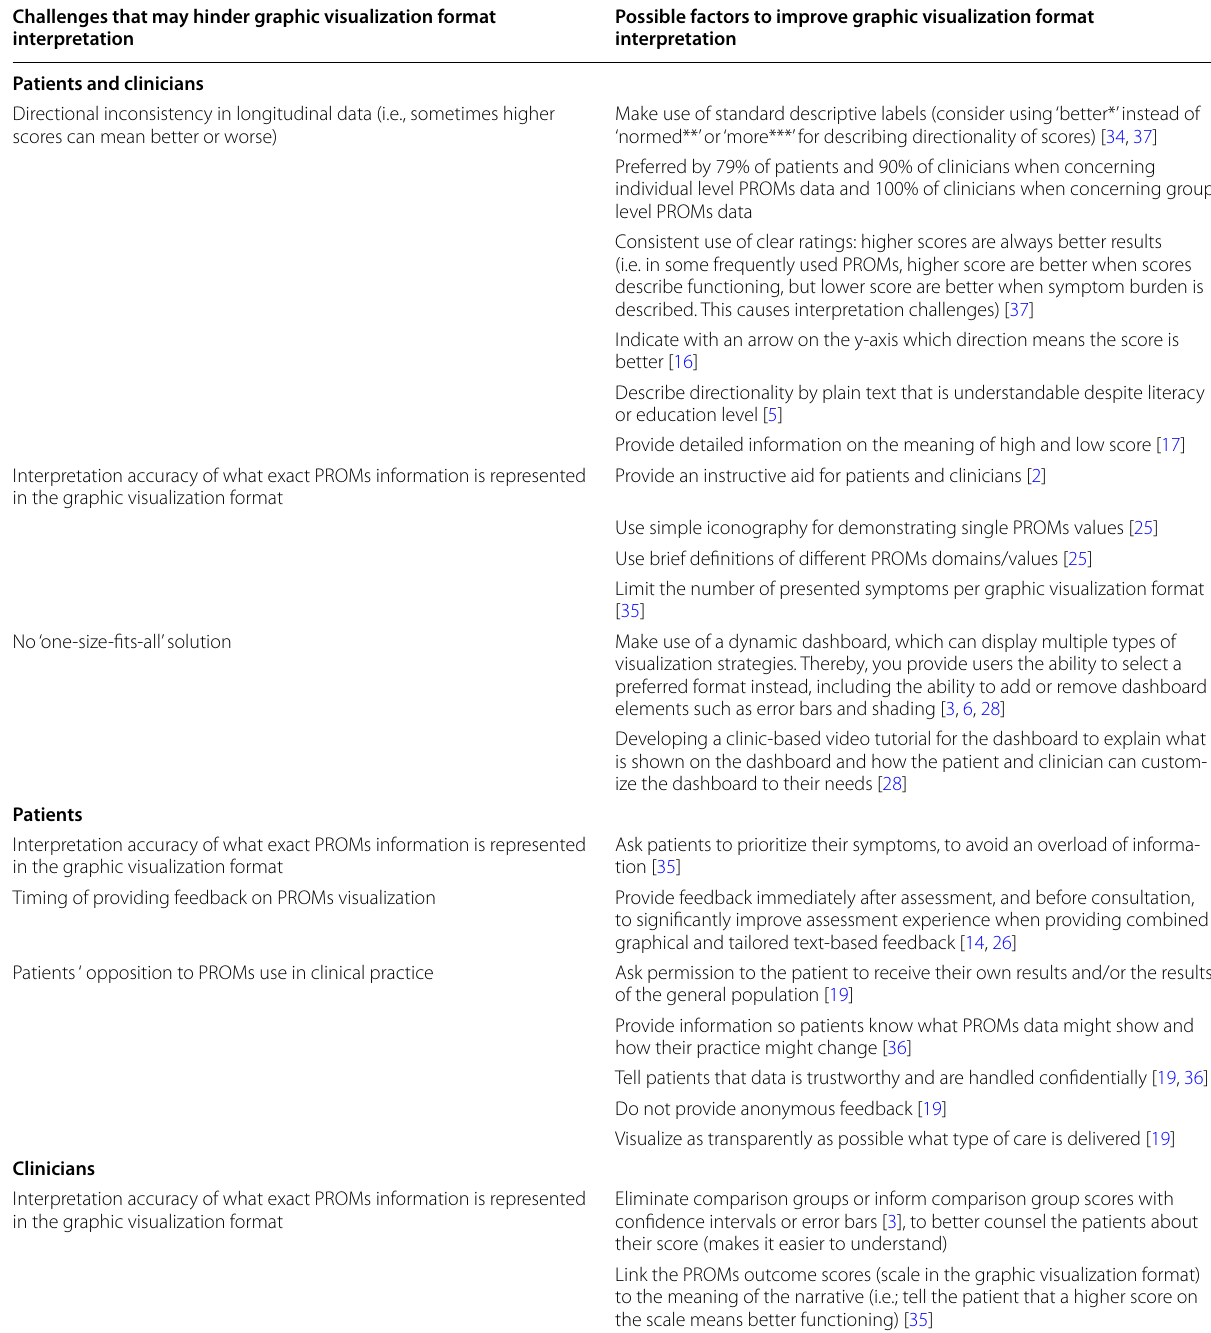
Table 3 Challenges and factors for improvement to consider when implementing visual individual PROMs feedback in clinical